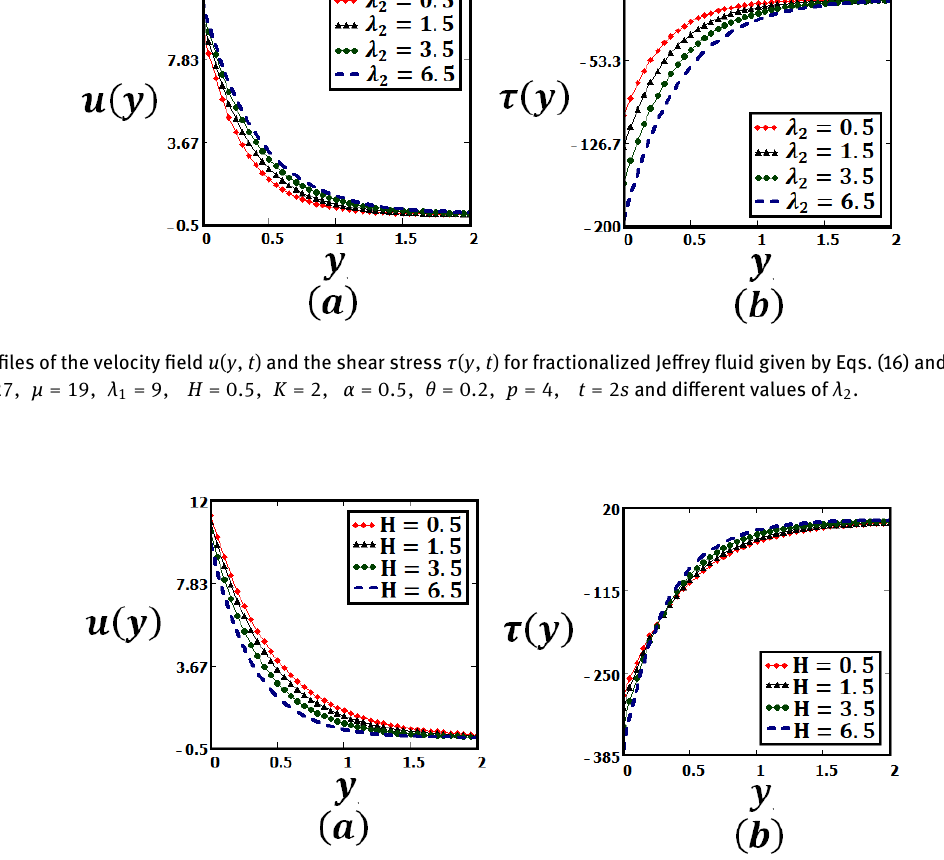
Figure 5: Profiles of the velocity field u ( y , t ) and the shear stress τ ( y , t ) for fractionalized Jeffrey fluid given by Eqs. (16) and (21), for A = 1, ν = 1.427, µ = 19, λ 1 = 3, λ 2 = 2, K = 2, α = 0.5, θ = 0.2, p = 4, t = 2 s and different values of H .